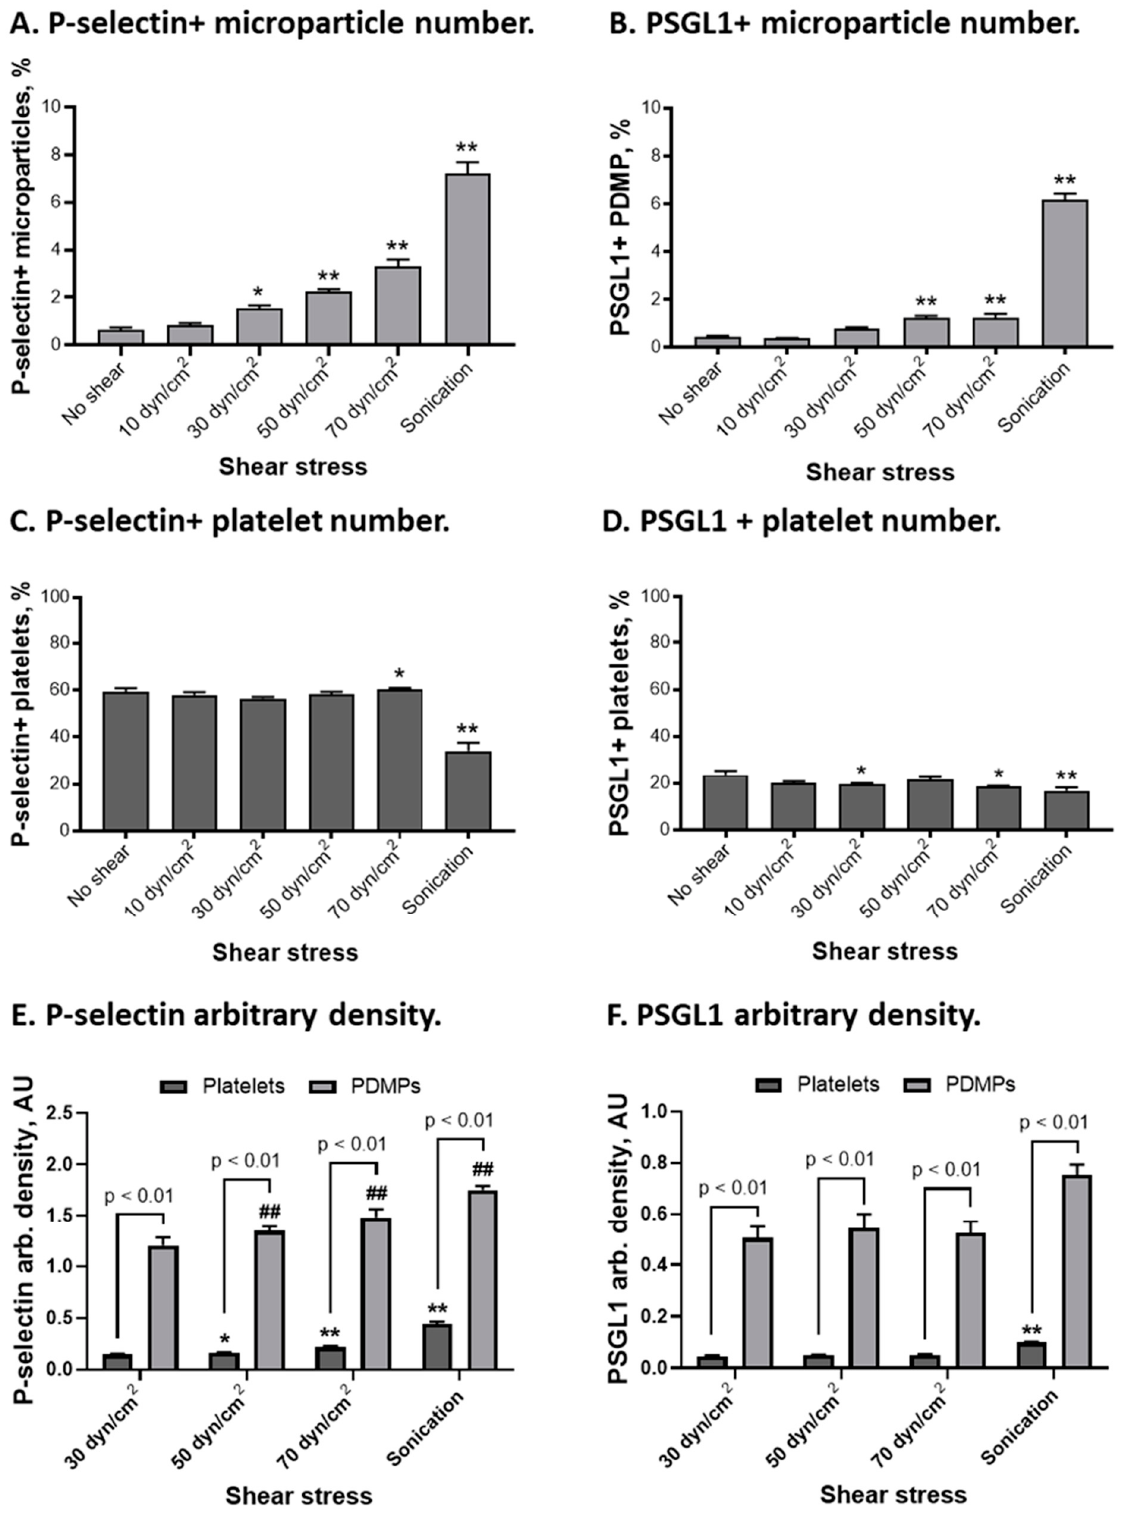
Figure 6. Distribution of P-selectin and PSGL1 on platelets and platelet-derived microparticles (PDMPs): ( A , B )—number of P-selectin+ platelets and PDMPs (CD62+/CD42+ particles), ( C , D )— number of PSGL1+ platelets and PDMPs (CD31+/PSGL1+ particles), ( E , F )—arbitrary density of P-selectin and PSGL1 on platelets and PDMPs. n = 7. Mean ± SEM, 1-way ANOVA followed by Dunnett multiple comparisons test: *— p < 0.05 and **, ##— p < 0.01 vs. no shear for platelets and PDMPs.